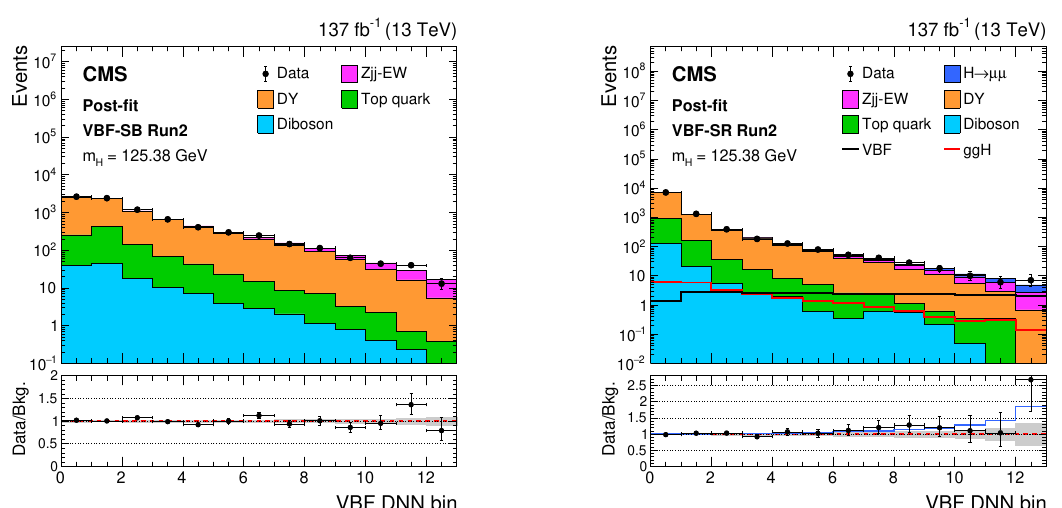
Figure 3 . The observed DNN output distribution in the VBF-SB (upper) and VBF-SR (lower) regions for the combination of 2016, 2017, and 2018 data, compared to the post-fit prediction from SM processes. The post-fit distributions for the Higgs boson signal produced via ggH (solid red) and VBF (solid black) modes with m = 125 . 38 GeV are overlaid. The lower panel shows the ratio H between data and the post-fit background prediction from the S+B fit. The best fit H → µ + µ − signal contribution for m = 125 . 38 GeV is indicated by the blue histogram (upper panel) and solid H line (lower panel), while the grey band indicates the total background uncertainty.